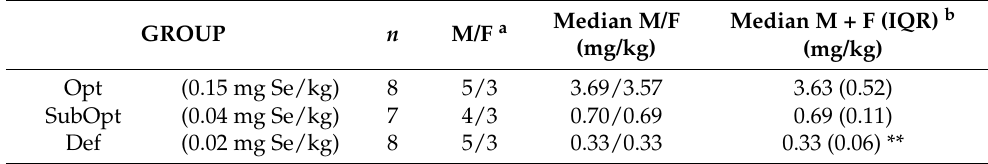
Table 2. Se liver levels in offspring at weaning (PND 23).